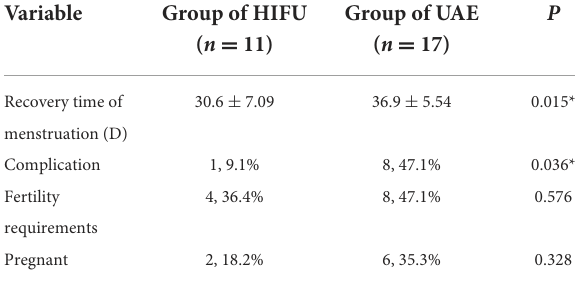
TABLE 2 Comparison of resident characteristics between HIFU and UAE group.